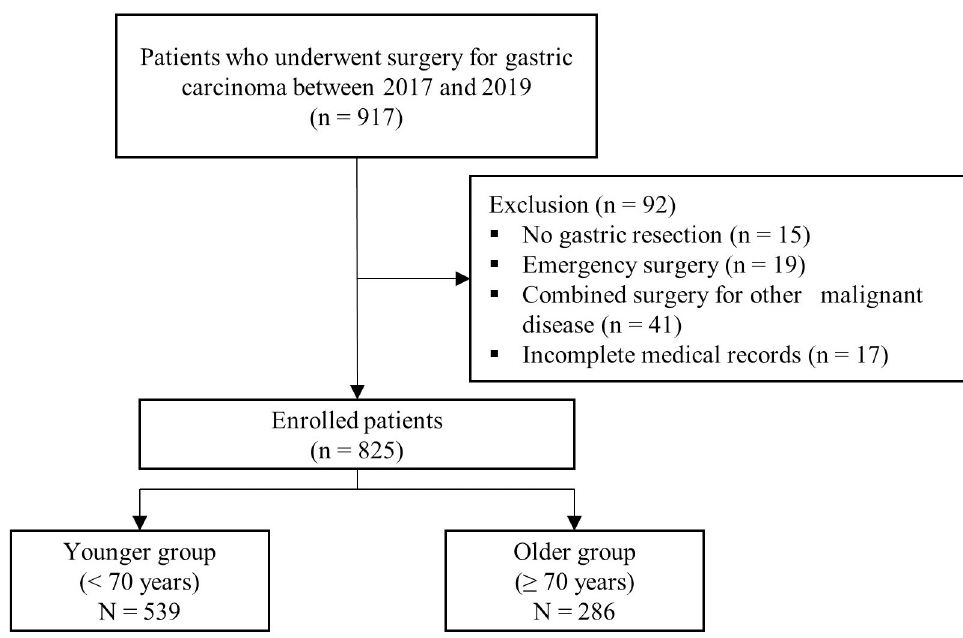
Fig 1. Flow diagram of